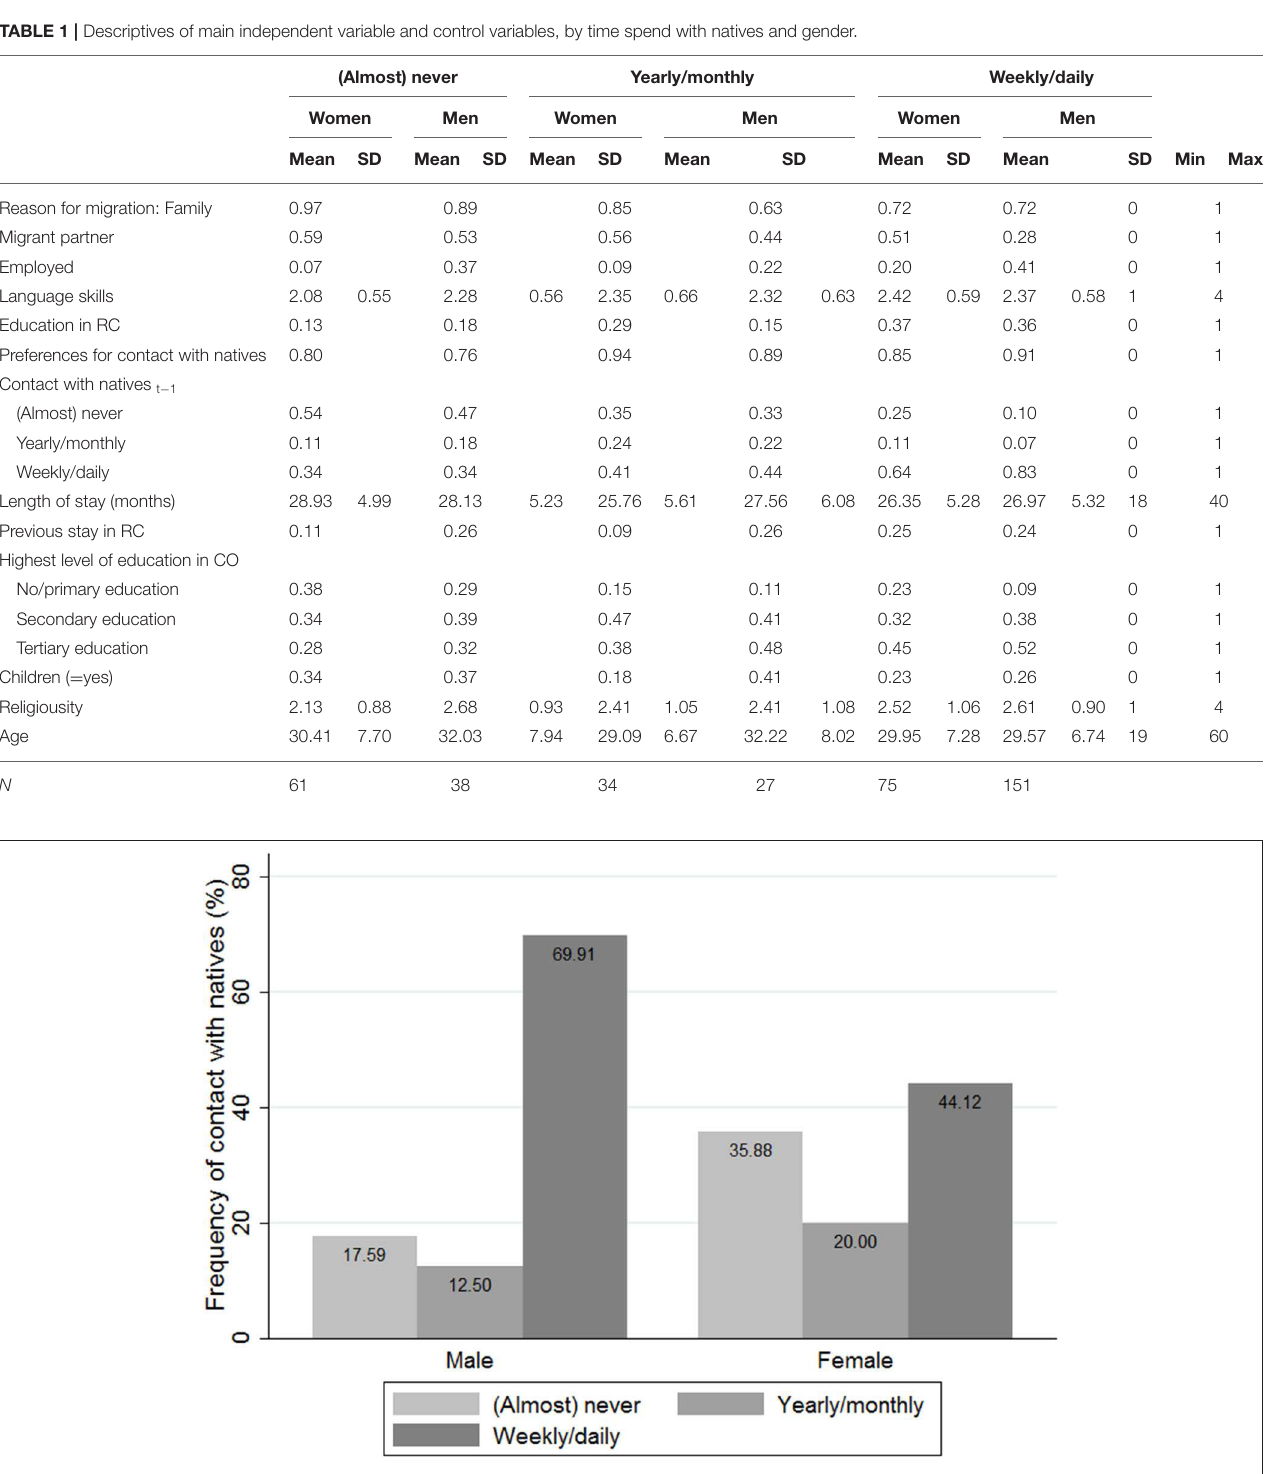
FIGURE 1 | Frequency of contact with natives (%), by gender. across the three groups. Last but not least, in all three groups Turkish men are higher educated, slightly older and less religious than Turkish women.